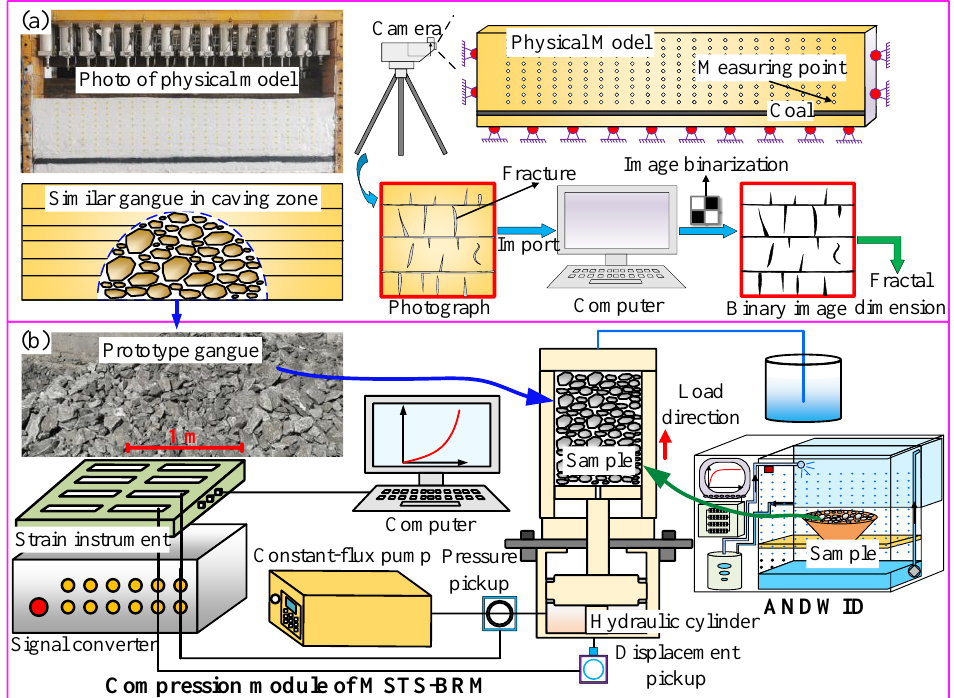
Figure 5. Test process. ( a ) Physical model test and ( b ) gangue compaction test.